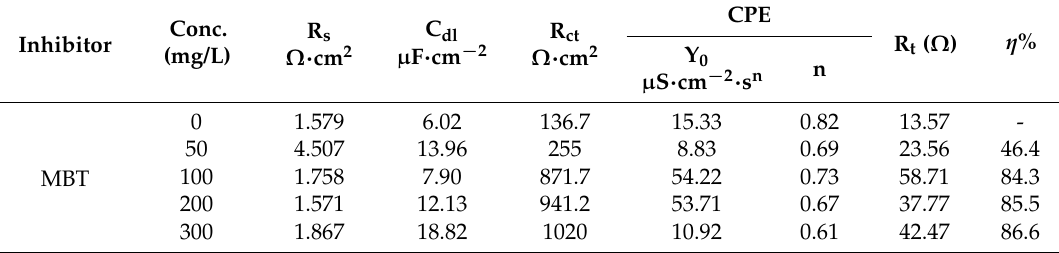
Table 4. Electrochemical impedance spectroscopy fitting parameters of different concentrations of MBT.